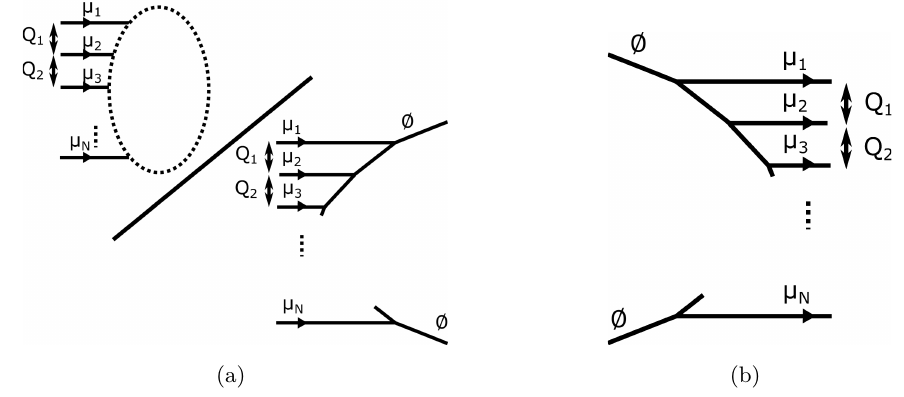
Figure 61. (a): The way of computing the contribution of each piece which we glue. (b): Another strip diagram. Combining this diagram with the diagram drawn in the denominator in figure 61(a) yields a diagram for a pure SU( N ) gauge